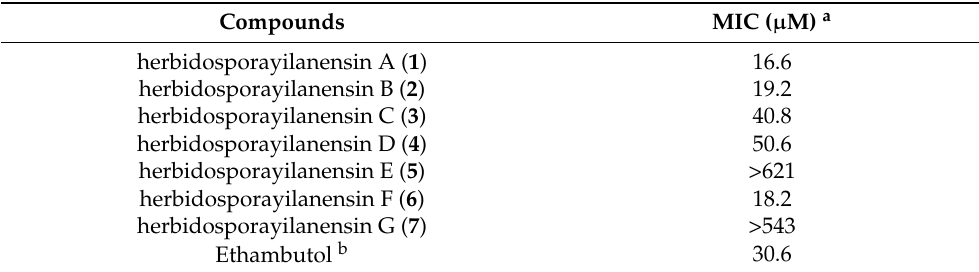
Table 3. Antimycobacterial effects of some isolates ( 1 – 7 ) from the cultures of one actinobacterium harbored in H . yilanensis on M. tuberculosis